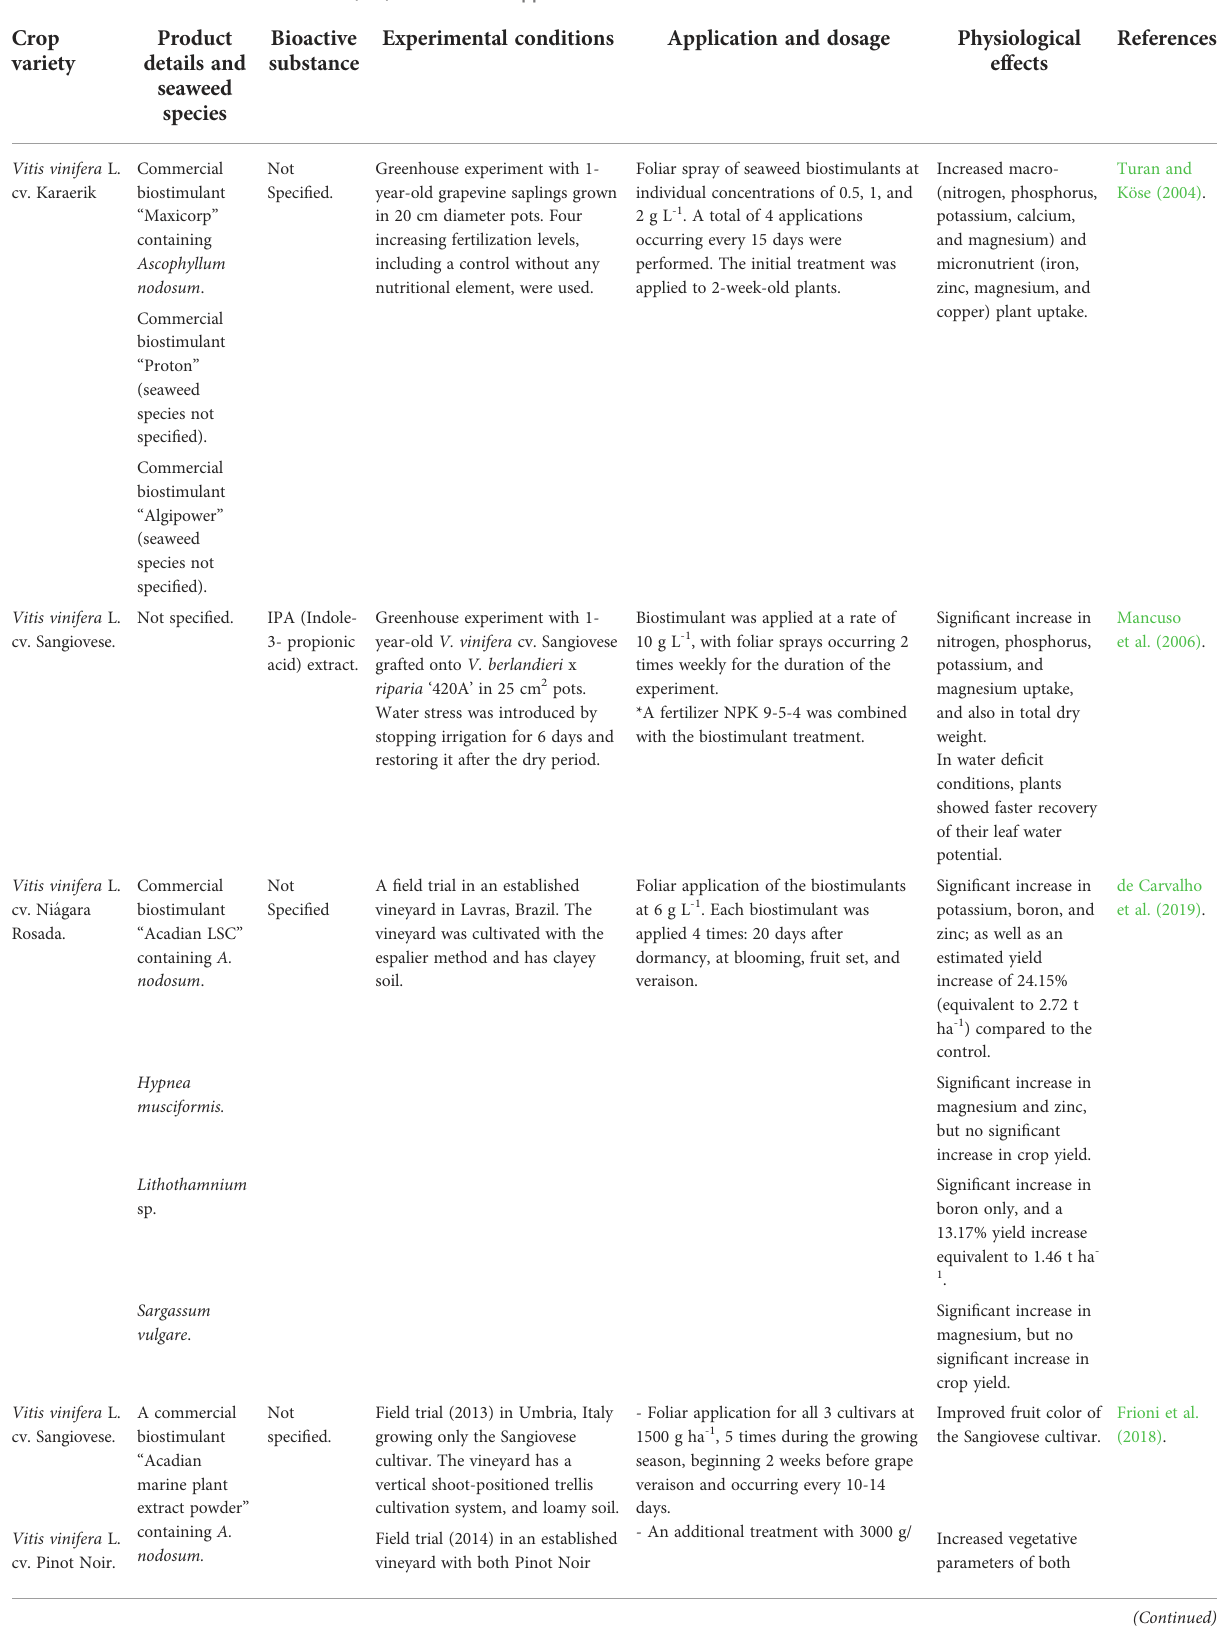
TABLE 2 An overview of seaweed-based (SEs) biostimulants applied in